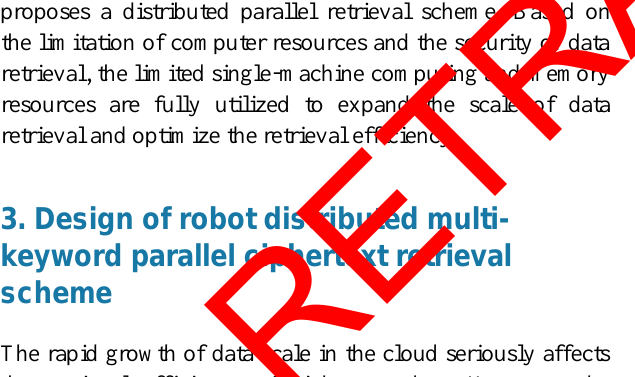
Figure 1. Distributed robot multi-keyword parallel ciphertext retrieval system